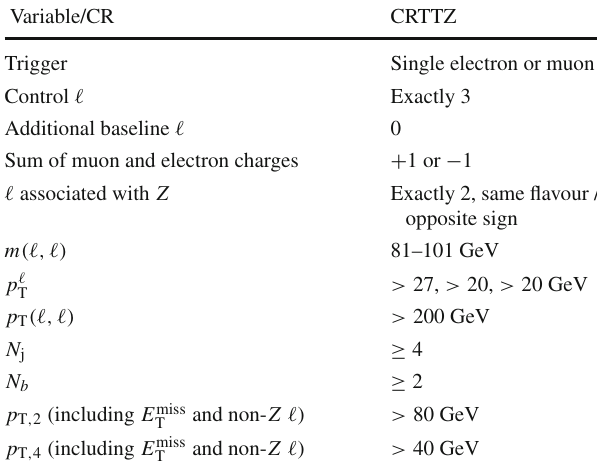
Table 6 Selection criteria for the t ¯ t + Z control region. The defin- ing extrapolation for these control regions is over the number of lep- tons; three leptons (a combination of electrons and muons) from W and Z decays is required, compared with zero leptons in the signal region. Variables for which the signal and control region requirements differ are highlighted by a thick border around the cell that contains the requirement. Requirements are made on the following variables in SRA and SRB but have no equivalent requirement in the con-